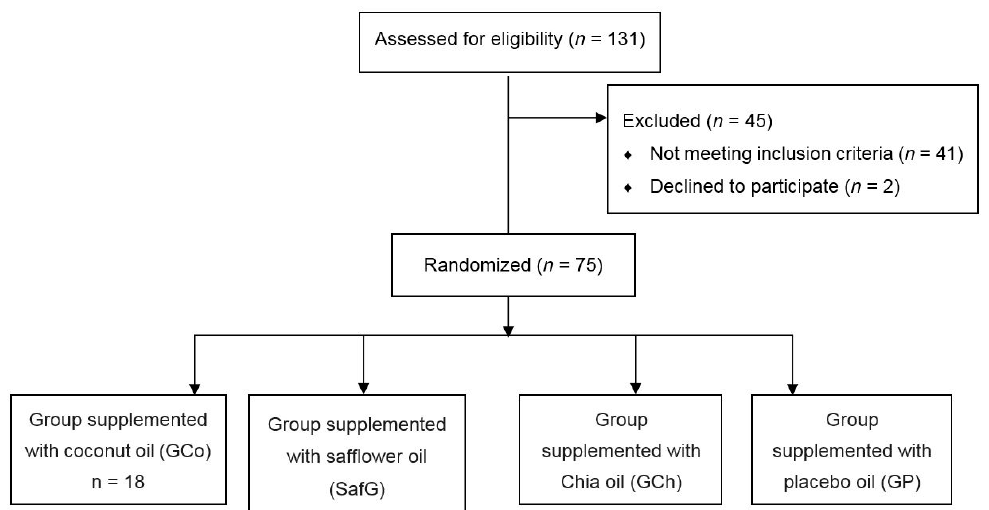
Figure 1. CONSORT diagram of participants representing the experimental groups. Anthropometric were evaluated one week before and one week after the end of the supplementation